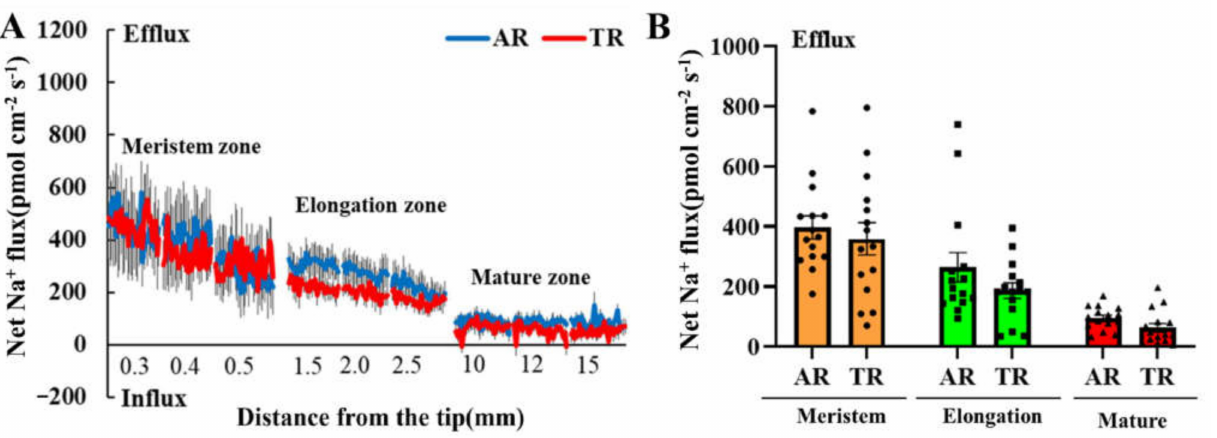
Figure 3. Effects of NaCl (200 mM) stress on steady-state Na + flow in different regions of root tips of transgenic roots (TRs) and adventitious roots (ARs) of IbIPUT1 . ( A ) Net Na + flux measurement via NMT in adventitious roots (ARs) and IbIPUT1 -transgenic roots (TRs). The steady-state Na + flux was measured from the meristem (300, 400 and 500 µ m from the tip), elongation (1.5, 2.0 and 2.5 mm from the tip) and mature (10, 12 and 15 mm from the tip) root zones, respectively, after 24 h of NaCl treatment (200 mM). Each measuring point is equivalent to the mean of at least 20 roots collected from 10 individual transgenic positive seedlings. ( B ) The histogram shows the average rate of net Na + flux in the meristematic zone, elongation zone and mature zone. The error bar represents the standard error of the average